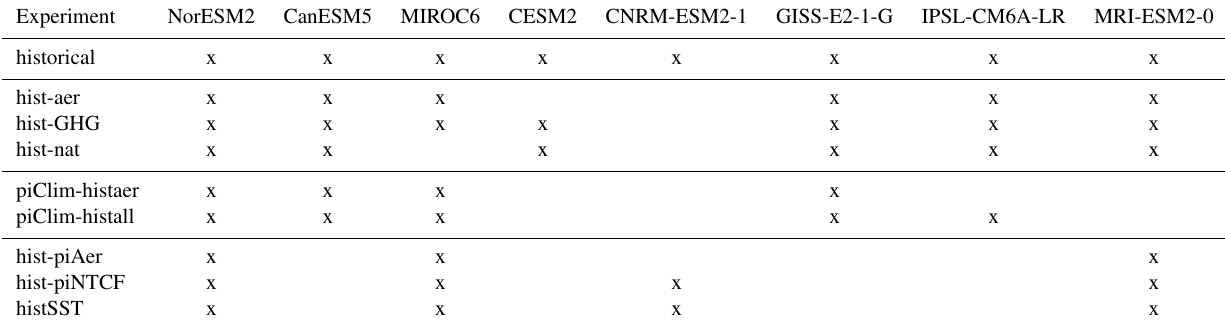
Table 1. Model participation, as used in this study, in CMIP6 model intercomparison projects (MIPs) and their experiments.